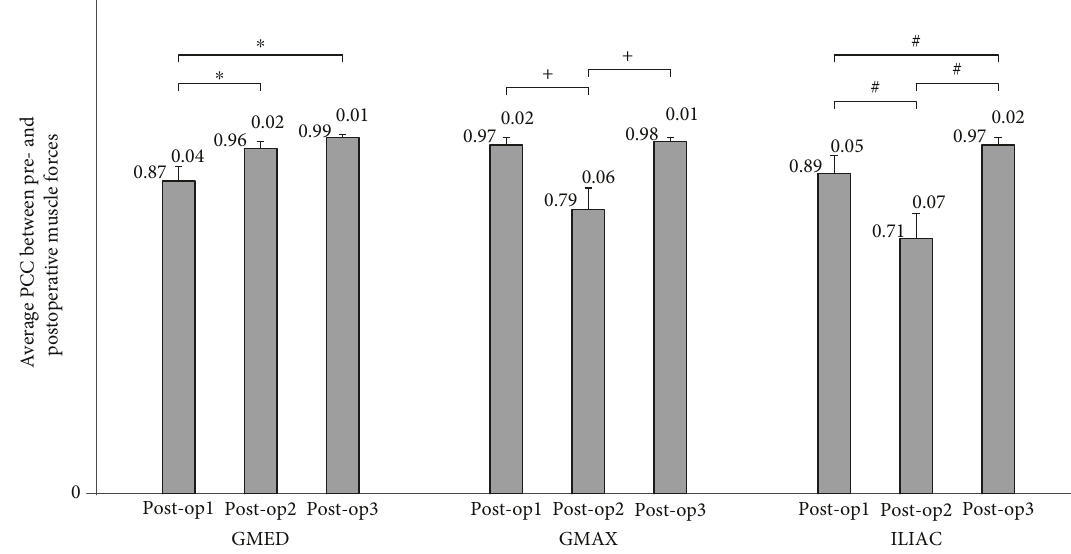
Figure 3: Mean ( ± standard deviation) Pearson correlation coe ffi cient (PCC) values between the pre- and three postoperative muscle forces. ∗ , +, # denote the statistical signi fi cance among intragroup